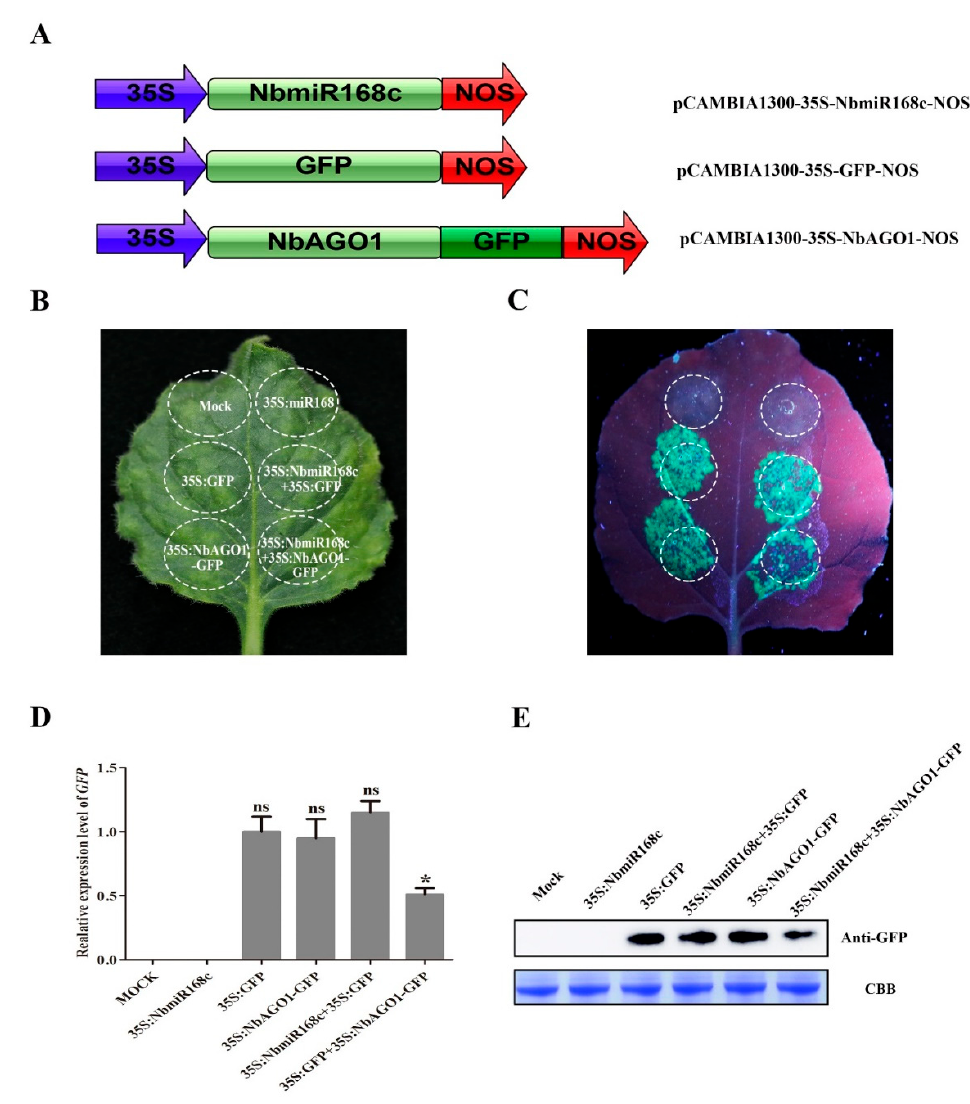
Figure 6. NbmiR168c regulates NbAGO1 expression by a post-transcriptional process in vivo. ( A ) Construction of NbAGO1-GFP fusion expression vector and NbmiR168c expression vector; ( B , C ) GFP fluorescence intensity of infiltrated sites of the leaf with different vectors; ( D , E ) accumulation of GFP was detected in different Nicotiana benthamiana leaves after 48 h of transient infection with different vectors by qRT-PCR and Western blotting—full WB images in Figures S4 and S5. * and ns showed significant and no significant differences between the two samples, respectively.